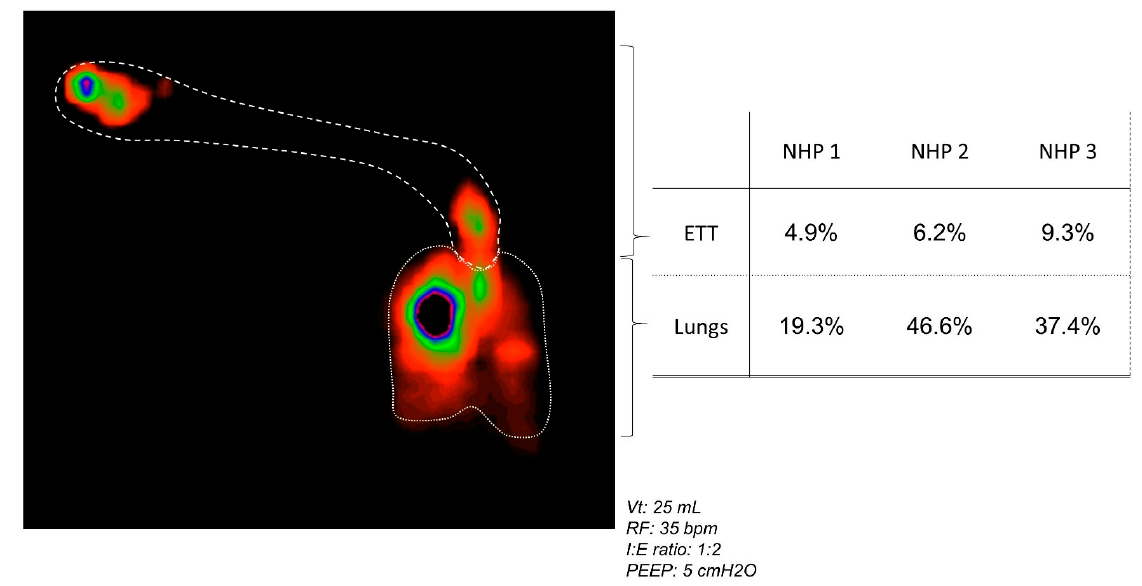
Figure 8. In vivo aerosol lung deposition. ( left ) Representative image of aerosol (AP-Phages + Tc99m-DTPA) deposition in intubated and mechanically ventilated non-human primates. The respiratory parameters were: 25 mL for tidal volume (Vt), 35 breaths per minute (bpm) for respiratory frequency (RF); an inspiratory: expiratory ratio of 1:2; 5 cm H 2 O for positive end expiratory pressure (PEEP). ( right ) Quantity of aerosol deposited in the lungs and endotracheal tube (ETT), and expressed as the percentage of the radiotracer quantity loaded in the nebulizer and given to each animal.